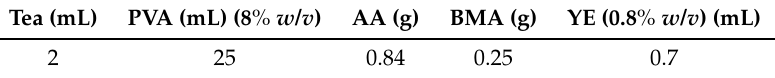
Figure 1. Experimental setup. BS: beam splitter, Mi: mirror, SFi: spatial filter, LP: lineal polarizer, Li: lens, Di: diaphragm, RIF: red interference filter and PC: data recorder. Table 1. Composition of liquid solution for PVA/AA-based